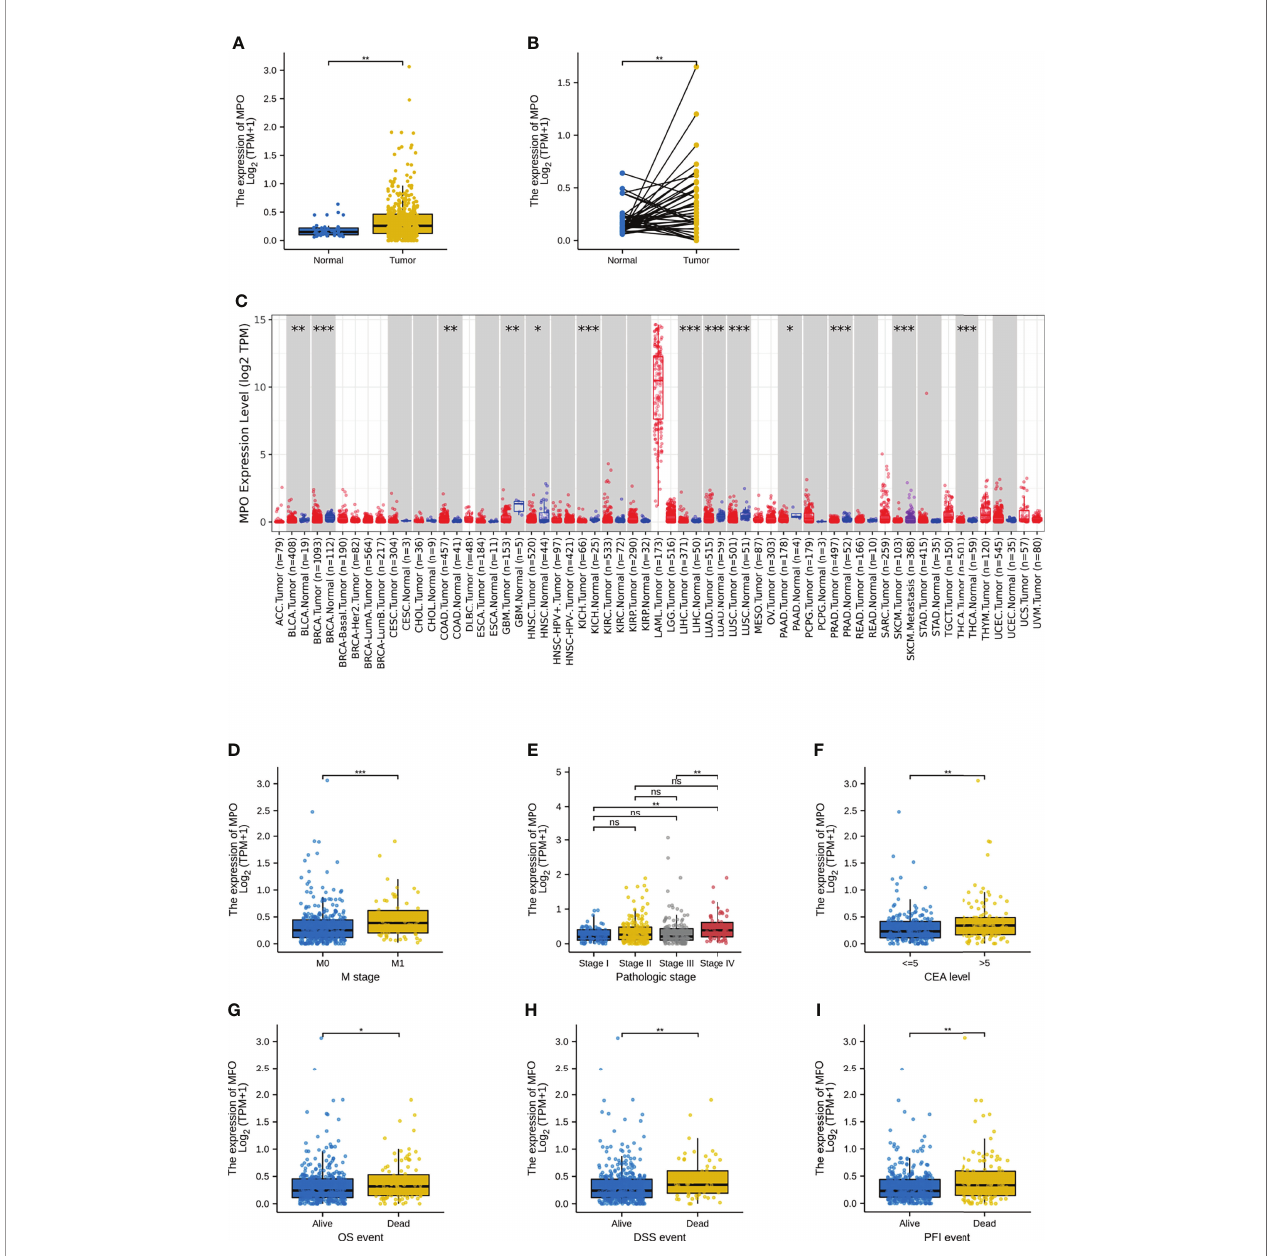
FIGURE 1 | MPO was upregulated in CRC and correlated with the malignant progression of CRC patients. (A) The MPO expression levels in 480 tumor tissues and 41 normal tissues. (B) The expression of MPO in 41 normal and matched tumor tissues. (C) MPO expression in several cancers in the TIMER2 database. (D – F) The association with elevated MPO and clinicopathological characteristics, including M stages, pathological stage, and CEA level. (G – I) The association with elevated MPO and death events, including OS events, DSS events, and PFI events. The difference was considered signi fi cant at * P < 0.05, ** P < 0.01, or *** P < 0.001. ns, no signi fi